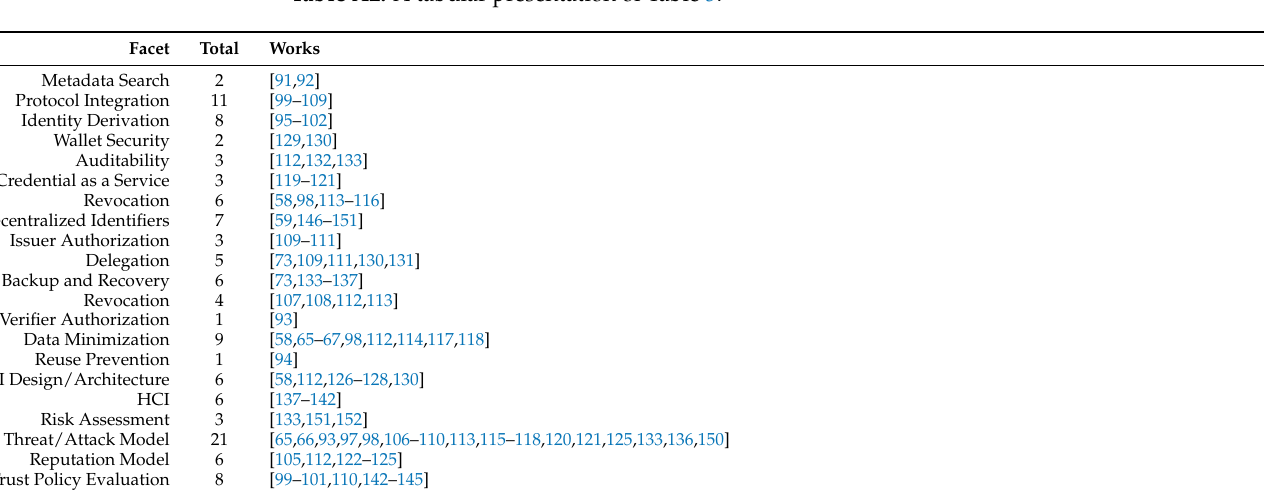
Table A2. A tabular presentation of Table